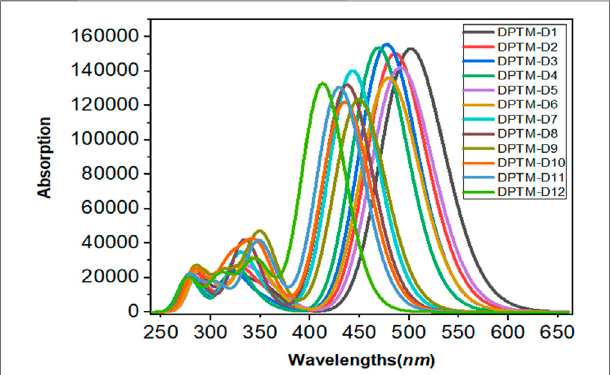
FIGURE4| Absorptionspectraofthedesignedcompounds(DPTM-1to DPTM-12).